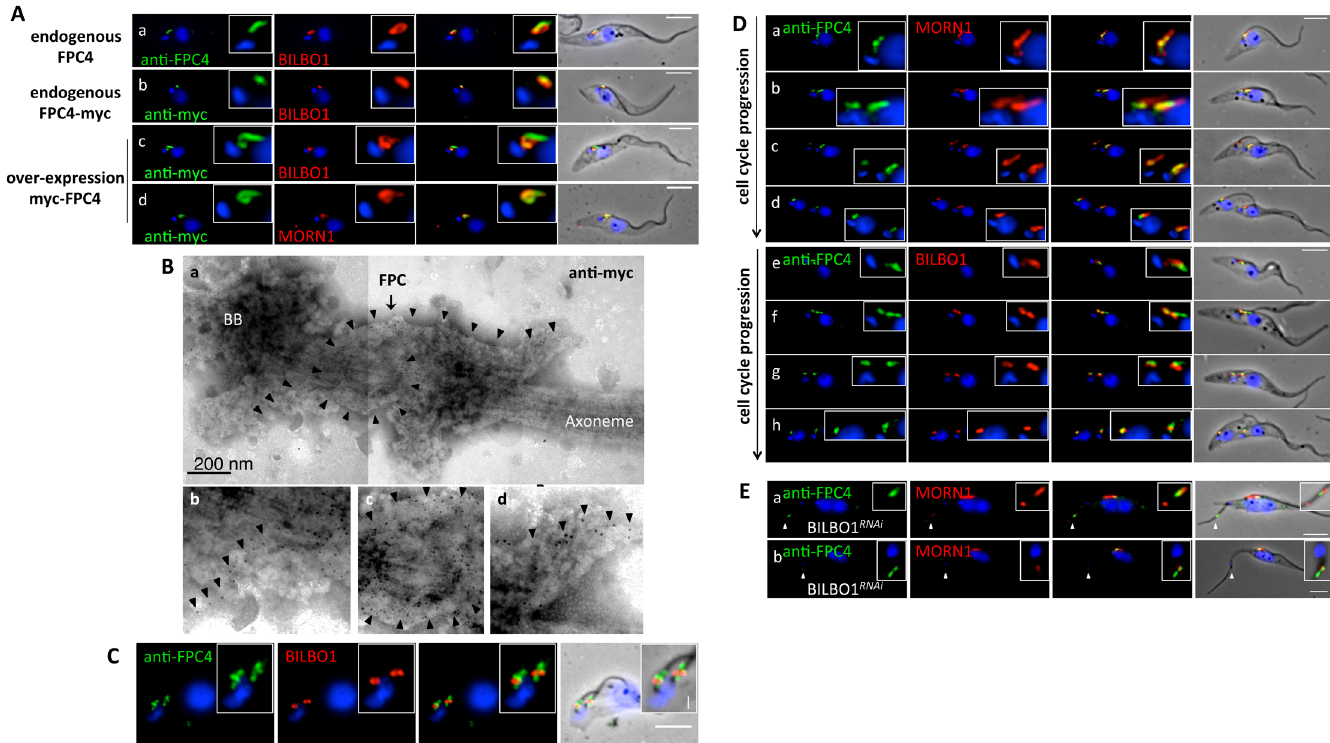
Fig 3. FPC4 is a hook complex and an FPC protein. (A) (a) Immunolabelling of endogenousFPC4 on cytoskeleton extracted cells from Tb 427 29–13 cells using the rat anti-FPC4 antibody. (b) Cytoskeletons from the cell line expressingendogenously myc-tagged FPC4 probedwith anti-myc. (c and d) Cytoskeletons from the cell line overexpressing myc-FPC4 using anti-myc. Co-labellingwith anti-BILBO1 (a, b, c) or anti-MORN1 (d). (B) Anti-myc immuno-electron microscopyon flagellaisolated from myc-FPC4 expressingcells (a), and the respectiveenlargements (b, c and d). (C) FPC4 immunolabellingusing anti-FPC4 on CK extracted Tb 42790–13 BSF cells. (D) Co-labellingon cytoskeleton extracted Tb 42729–13 cells using anti-FPC4 and anti-MORN1 (a-d), and rat anti-FPC4 and anti-BILBO1 (e-h). (E) BILBO1 RNAi was inducedfor 36 h and cells were detergent extracted and probedwith rat anti-FPC4 (green)and anti-MORN1 (red). The white arrowheads indicatethe area that is enlargedin the zoom image and highlightthe labellingof FPC4 and MORN1 within the new detachedflagellum (a) and at the base of the axonemeof the new detachedflagellum(b). Kinetoplasts and nuclei were DAPI stained in A, C, D and E. Scale bars in A, C, D, and E represent 5 μ m. In A c and d where the cells were inducedfor 24 h. All the experiments were performed more than three